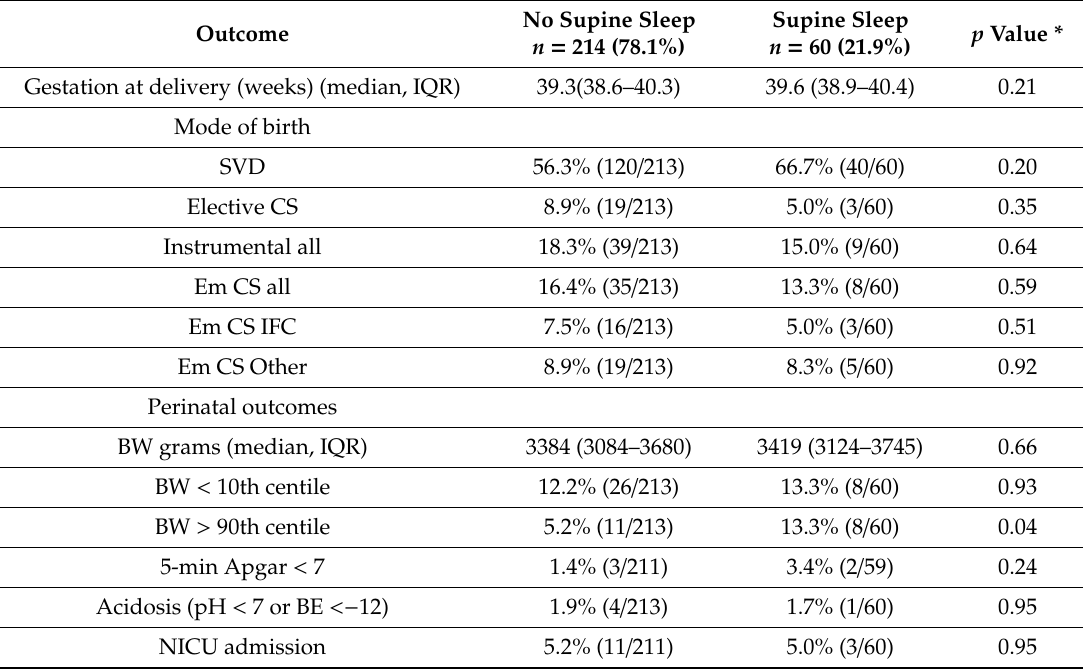
Figure 2. Maternal supine sleep position and cerebroplacental ratio (CPR) centile. Table 3. Intrapartum and perinatal outcomes by maternal sleep